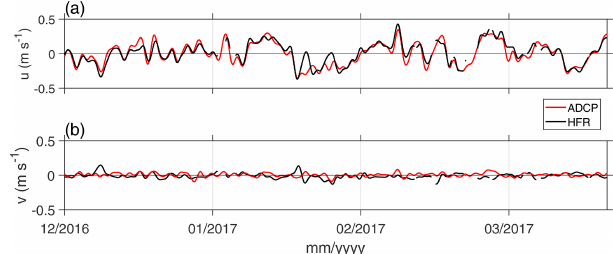
Figure 4. Comparison of the flow velocity (ms − 1 ) recorded by an ADCP at Cacela station (red lines) with the velocity at the nearest HFR grid node (black lines) from December 2016 to April 2017: (a) eastward component u and (b) northward component v .